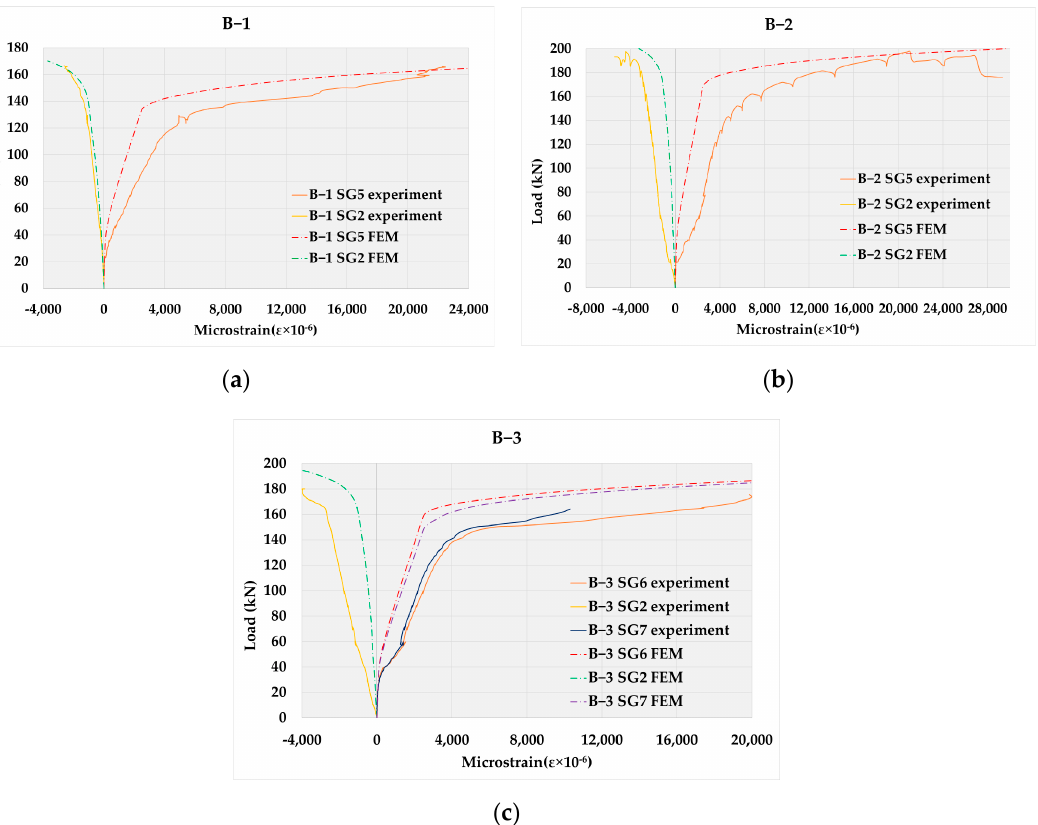
Figure 14. Load vs. microstrain curves in tensioned reinforcement in Section III for: ( a ) Beam B − 1; ( b ) Beam B − 2; ( c ) Beam B − 3.